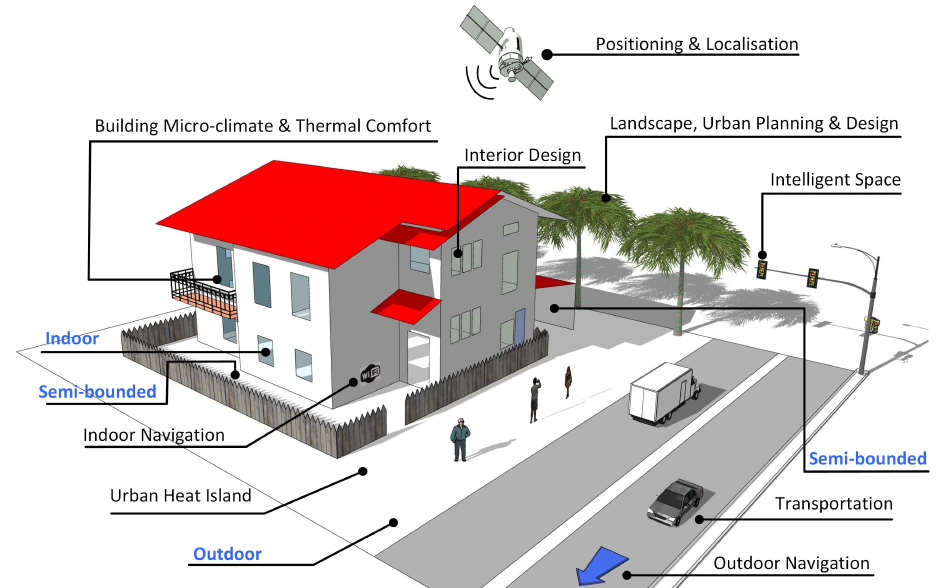
Figure 1. The domains in spatial science and urban applications that introduced